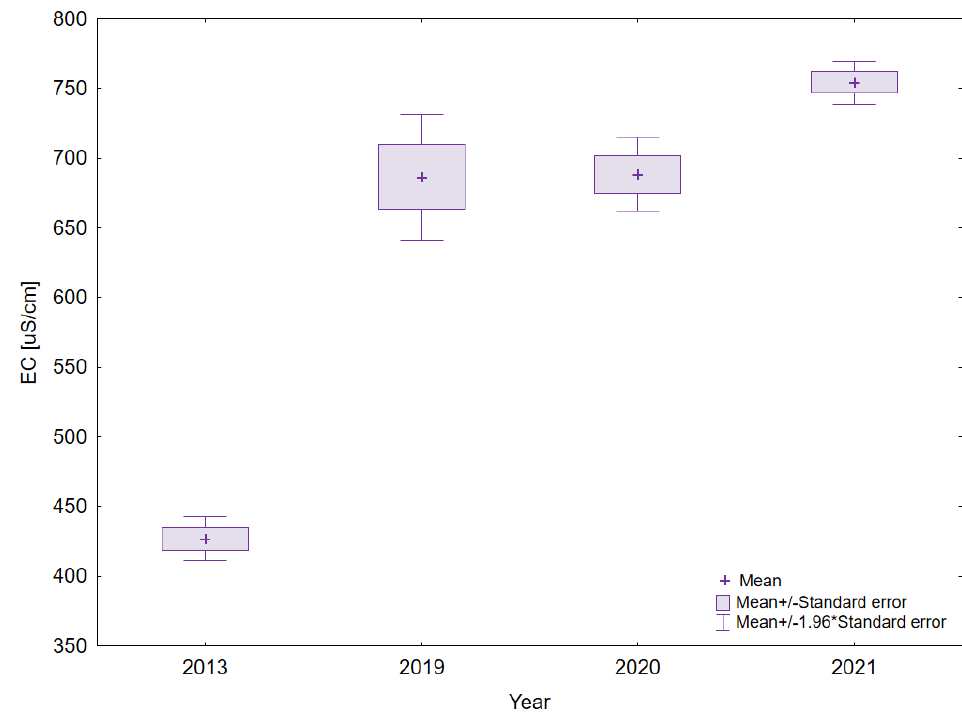
Figure 9. Average annual values of EC in the water of Lake Mielenko.